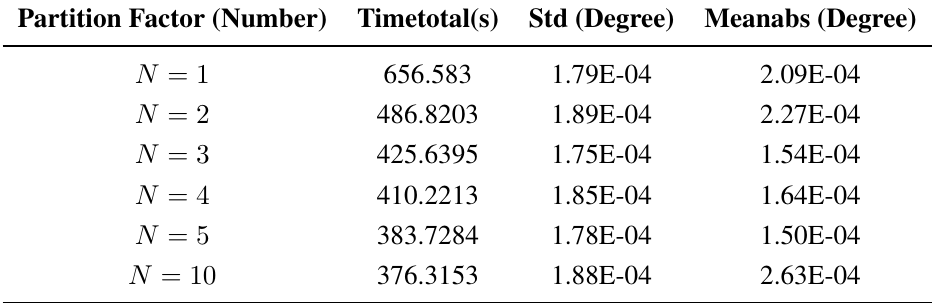
Table 3. Decomposition algorithm evaluation of compensating for random errors.